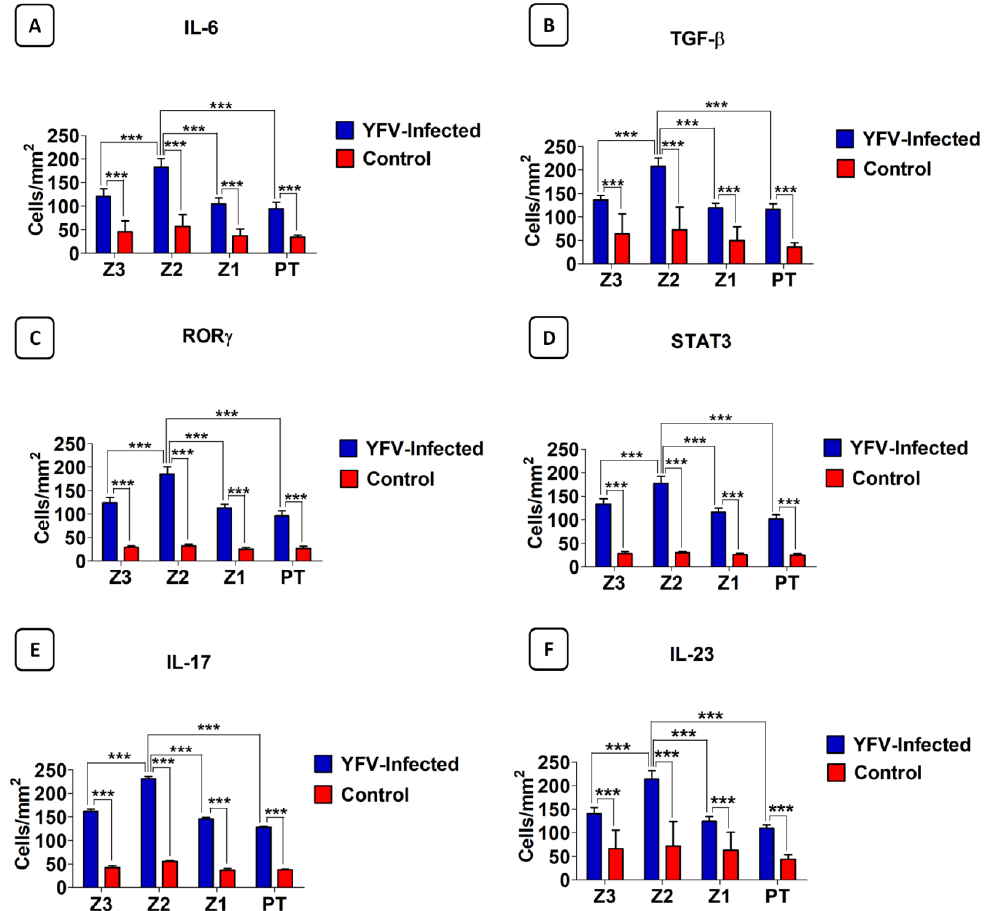
Figure 4. Quantitative analysis for IL ‐ 6 ( A ), TGF ‐β ( B ), ROR ‐γ ( C ), STAT3 ( D ), IL ‐ 17A ( E ), and IL ‐ 23 ( F ) in zones Z3, Z2, and Z1 of acini and PT in the liver parenchyma of 21 patients with fatal YF compared to the 05 normal controls. Z3: Pericentral zone; Z2: Midzonal zone; Z1: Periportal zone; PT: